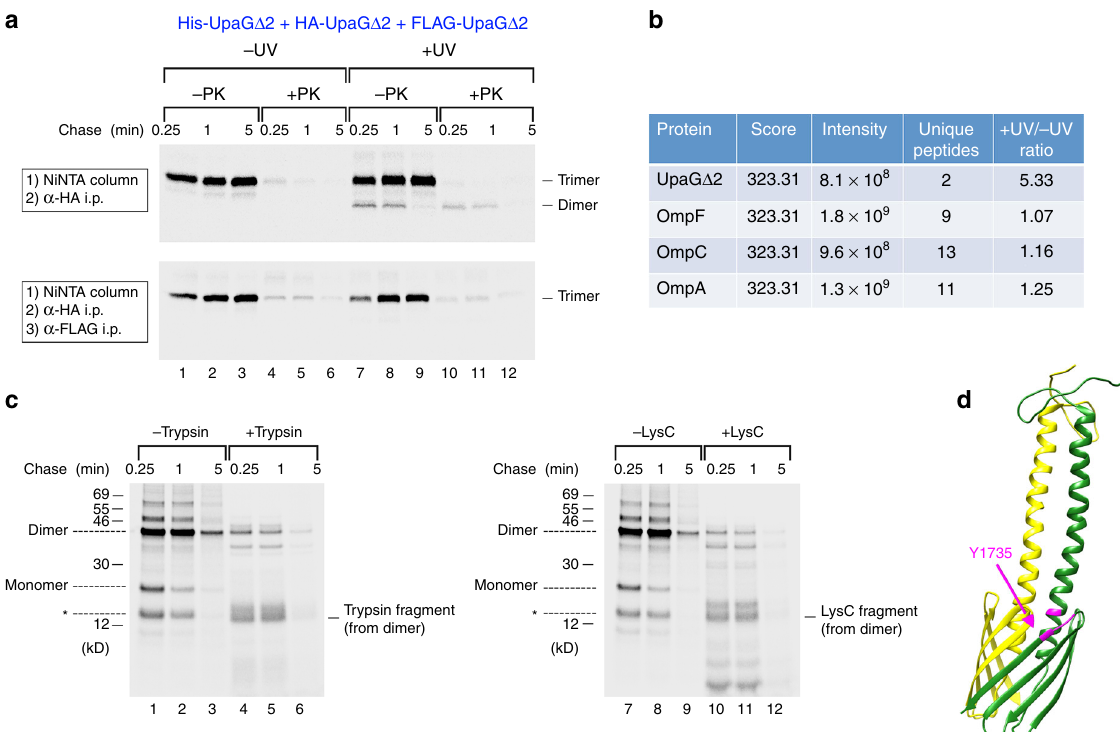
Fig. 3 The UpaG Δ 2 crosslinking product is a homodimer. a AD202 transformed with pRS9 [P trc - His 10 -upaG Δ 2(Y1735am) + HA-upaG Δ 2(Y1735am) + FLAG- upaG Δ 2(Y1735am) ] and pDULE-Bpa were subjected to pulse-chase labeling. Half of the cells were UV irradiated, and half of both the irradiated and non- irradiated samples were treated with PK. His 10 -tagged proteins puri fi ed by Ni-NTA chromatography were then subjected to immunoprecipitation with an anti-HA antiserum (top gel) or sequential immunoprecipitations with anti-HA and anti-FLAG antisera (bottom gel). b AD202 were transformed with pRS5 [P trc - His 10 -upaG Δ 2(Y1735am) ], and half of the cells were UV irradiated. His 10 -tagged proteins were puri fi ed from cell membranes by Ni-NTA chromatography and resolved by SDS-PAGE. Proteins in the ~40 kD range puri fi ed from both irradiated and non-irradiated were extracted, labeled with light and heavy isotopes, respectively, and analyzed by quantitative mass spectrometry. The MaxQuant score and intensity of each protein and its relative abundance in the two samples are shown. c AD202 transformed with pRS4 [P trc - HA-upaG Δ 2(Y1735am) ] and pDULE-Bpa were radiolabeled, UV irradiated, and treated with PK. After proteins were TCA precipitated, immunoprecipitations were conducted using an anti-HA antiserum. One half of each sample was then treated with trypsin or Lys-C. d Structure of two subunits of Hia 27 visualized using UCSF Chimera software (http://www.rbvi.ucsf.edu/chimera). The conserved tyrosine (Y1055) that is equivalent to UpaG Y1735 in one subunit and all residues located within 4 Å in the adjacent subunit are shown